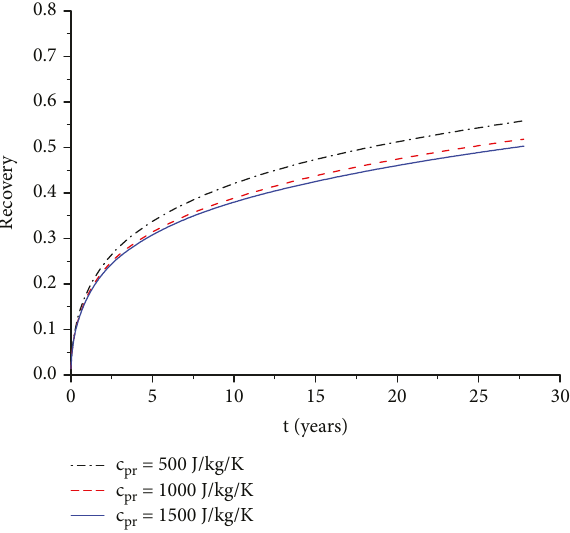
Figure 12: E ff ect of gas thermal conductivity on shale gas recovery.